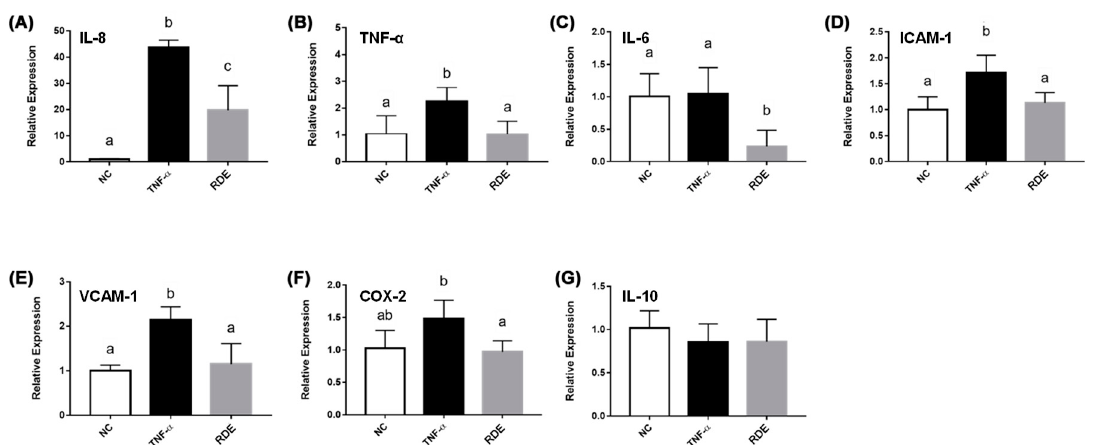
Figure 3. Gene expression of inflammatory mediators in no treatment (NC), TNF- α treated (TNF- α ), or RDE then TNF- α treated (RDE) Caco-2 cells. Caco-2 cells were pretreated with 50 µ g / mL of RDE for 1 h, followed by 2 ng / mL TNF- α incubation for another 4 h. The relative mRNA expression was measured by real-time PCR. Gene expressions of ( A ) IL-8, ( B ) TNF- α , ( C ) IL-6, ( D ) ICAM-1, ( E ) VCAM-1, ( F ) COX-2, and ( G ) IL-10 are shown. Values are presented as means ± SEM, n = 4. Shared letters indicate no significant di ff erence ( p > 0.05).